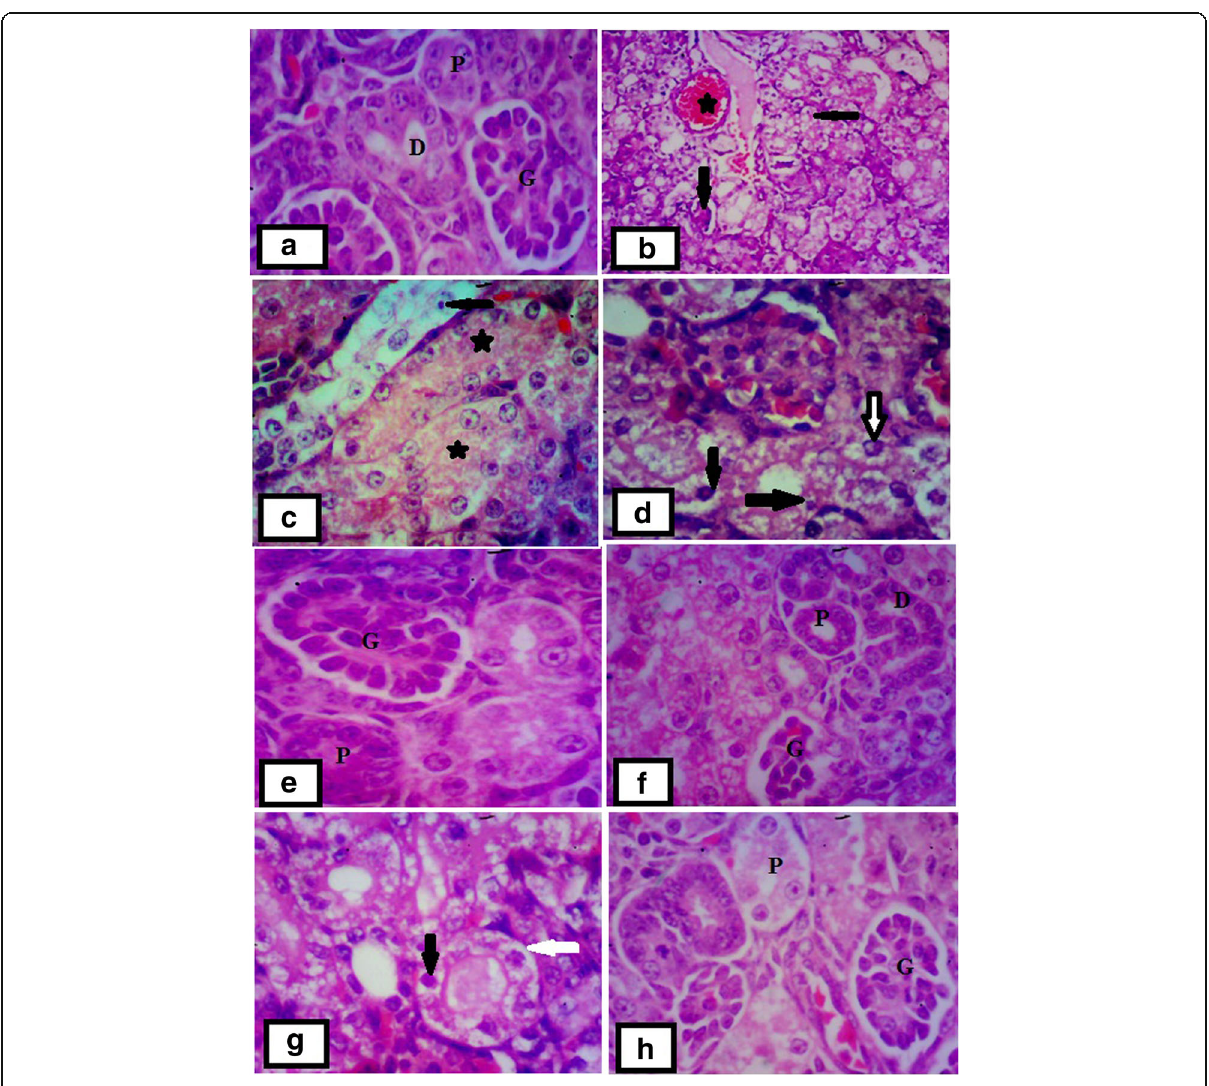
Fig. 7 Photomicrographs from the kidney tissues of 18-day-old fetuses in control and treated groups stained with H&E stain. The kidney tissue of control (GI) showing Malpighian corpuscles (G), the proximal (P), and distal convoluted tubules (D) ( a ) (×40). For the kidney of diabetic group (GII) showing venous congestion (asterisk), shrinkage glomerulus (thick arrow), hydropic degeneration (arrow) ( b ) (×20) and necrosis of the epithelial cells lining numerous tubules (black and white arrows) ( c , d ) (×40), in addition of hyaline casts (stars) ( c ) (×40). The kidney section from GIII revealed somewhat normal tissue characteristics ( e ) (×40). GIV showing signs of tissue repair ( f – h ) (×40) but some renal tubules have degenerative cells (white and black arrows) some blood